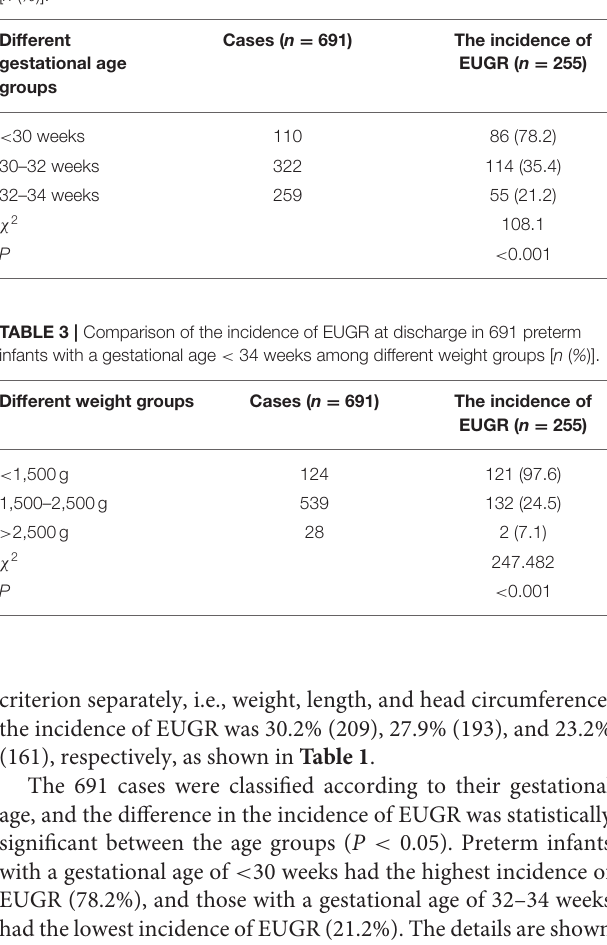
TABLE 2 | Comparison of the incidence of EUGR at discharge in 691 preterm infants with a gestational age < 34 weeks among different gestational age groups [ n ( % )].